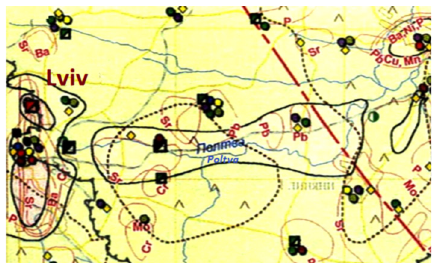
Figure 2. Tectonic zoning of the studied region (source: Krupsjkyj,